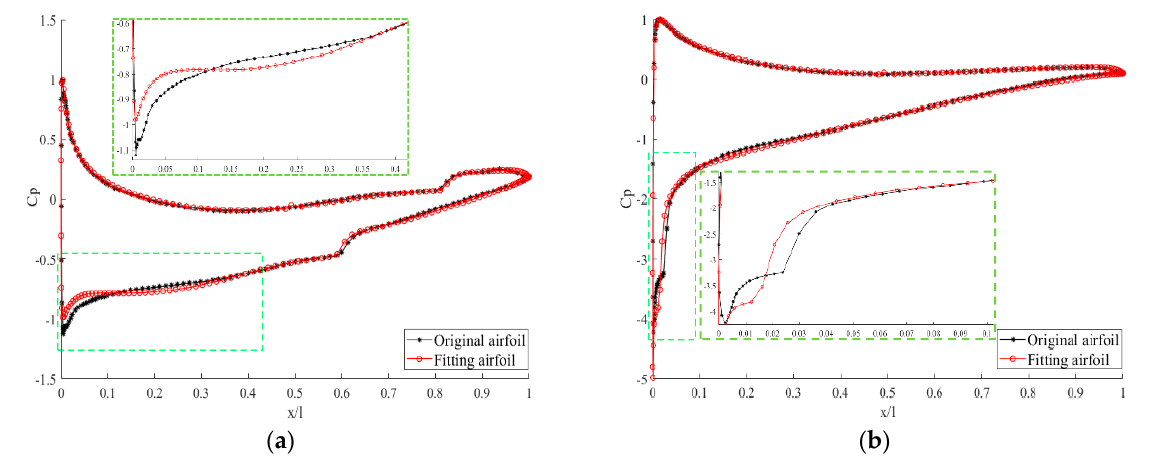
Figure 11. Pressure distribution. ( a ) AoA = 3°; ( b ) AoA = 8°.